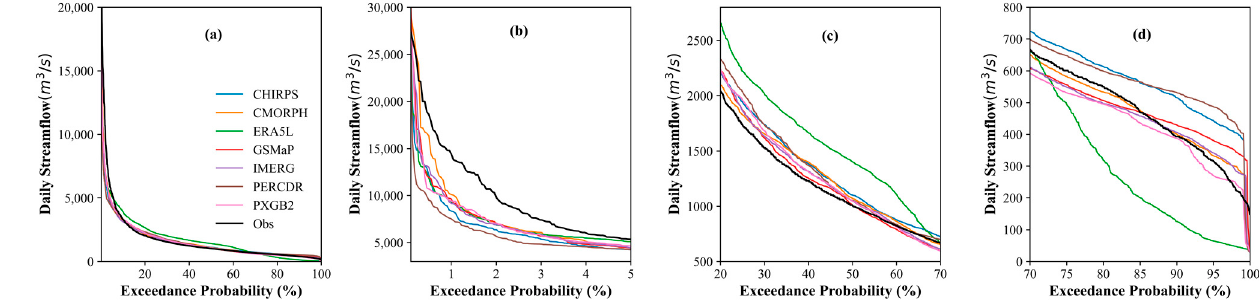
Figure 9. Comparison of the exceedance probabilities of the observed and simulated daily streamflow during the whole period under scenario II.